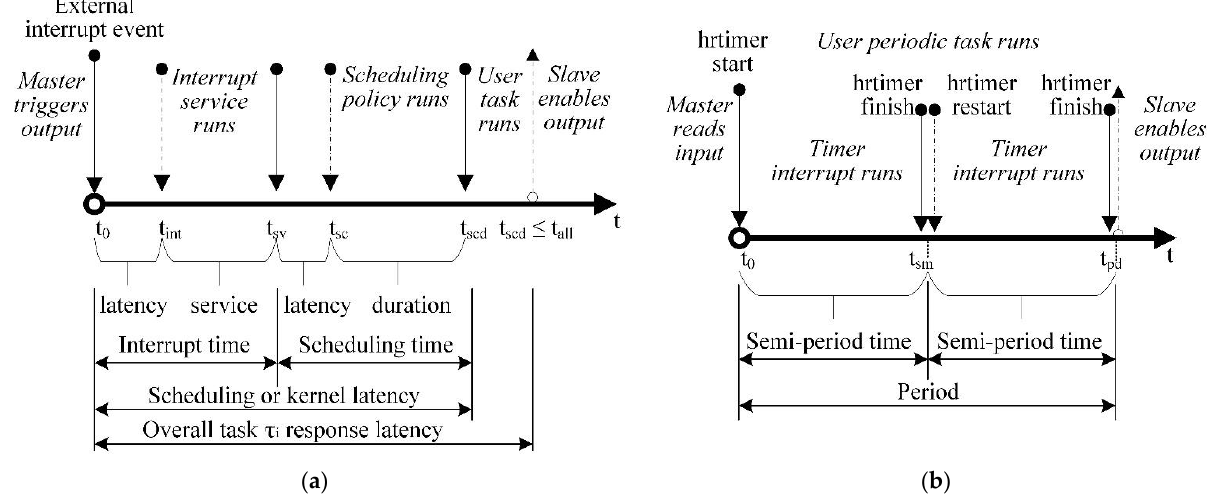
Figure 2. Response and periodic tasks: ( a ) overall response task latency; ( b ) periodic task time interval.